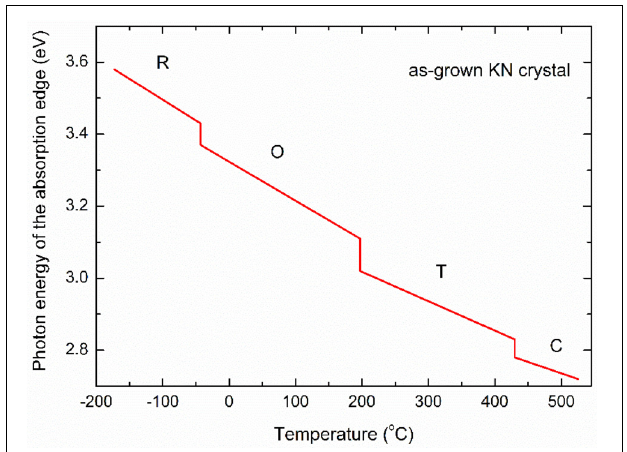
FIGURE 8 | Temperature dependence of the forbidden band width of undoped KN crystal. [Redrawn from Kaifu and Komatsu (Kaifu et al.,